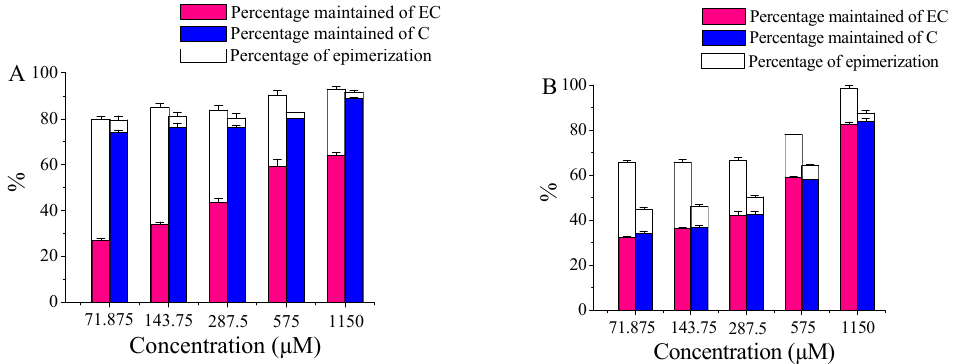
Figure 2. The effect of substrate concentration on the percentage of epimerization and percentage maintained of EC and C under 6 h UVB radiation: ( A ) water and ( B ) ethanol.